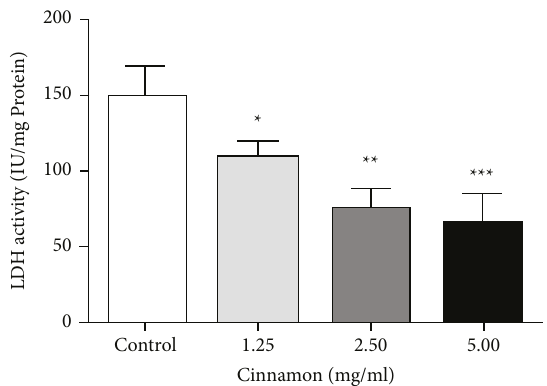
Figure 5: Effect of different concentrations of Cinnamon aqueous extract on LDH activity in5637cells. Data are reported as the mean ± SD. All reported value is the average of at least three in- dependent replicates. ( ∗ P < 0 . 05, ∗∗ P < 0 . 01 and ∗∗∗ P < 0 . 001 compared to control group). LDH: lactate